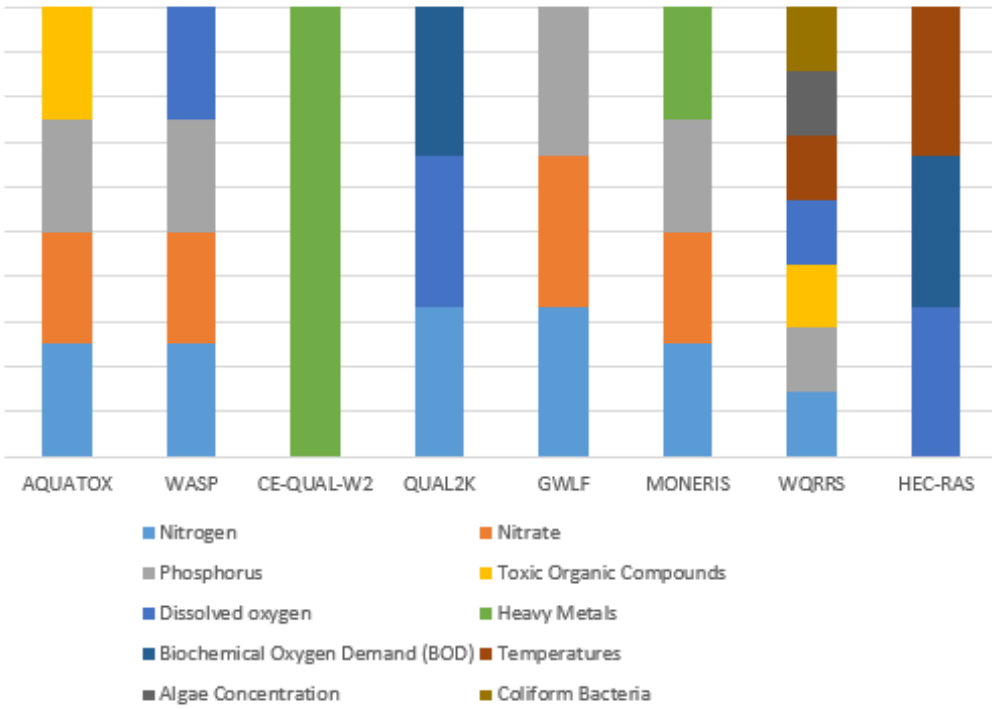
Figure 1. Comparative analysis of software tools for dynamic simulation of water quality